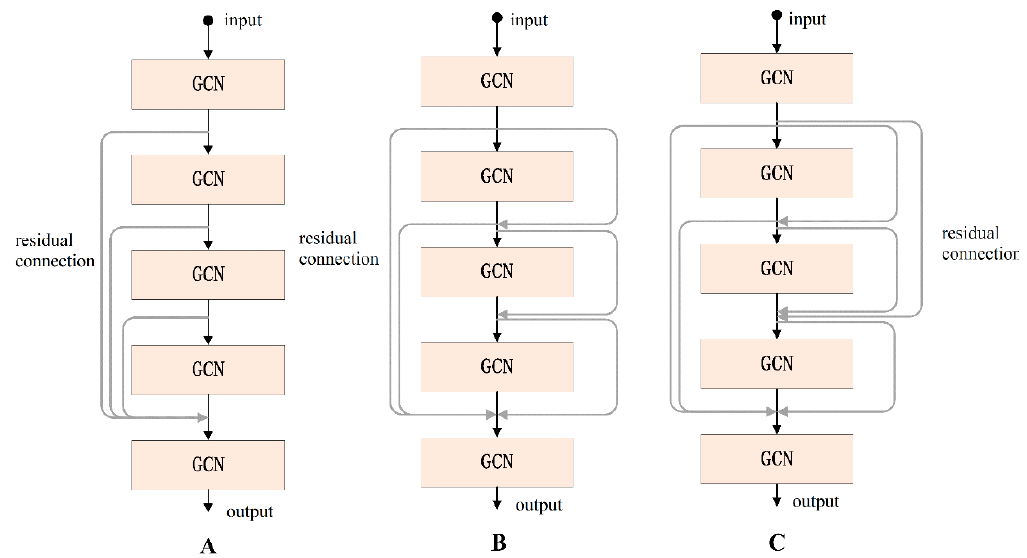
Figure 6. Three types of residual connections.